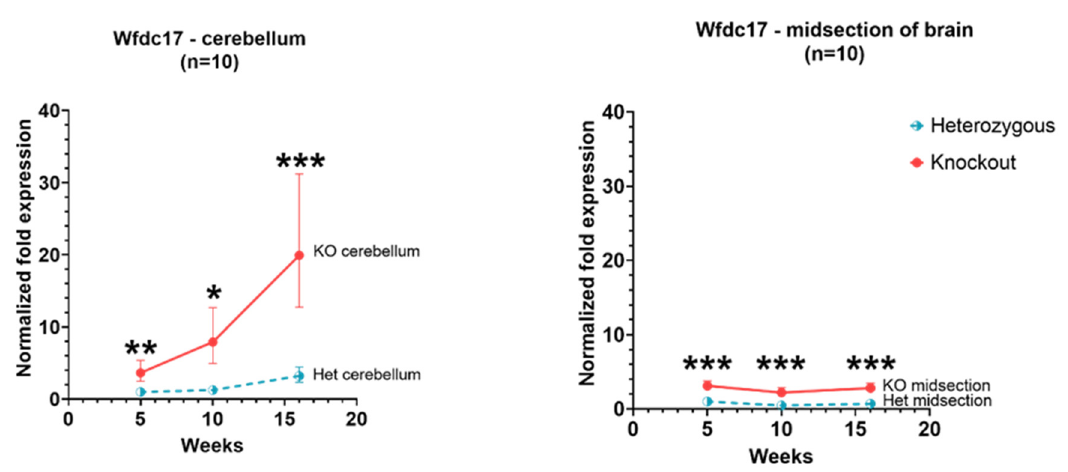
Figure 1. Relative Wfdc17 expression in the cerebellum and cerebral cortex of Hexb -KO Sandhoff disease mouse model (*— p value < 0.05; **— p value < 0.01; ***— p value < 0.001; midsection of brain represents cerebral cortex).